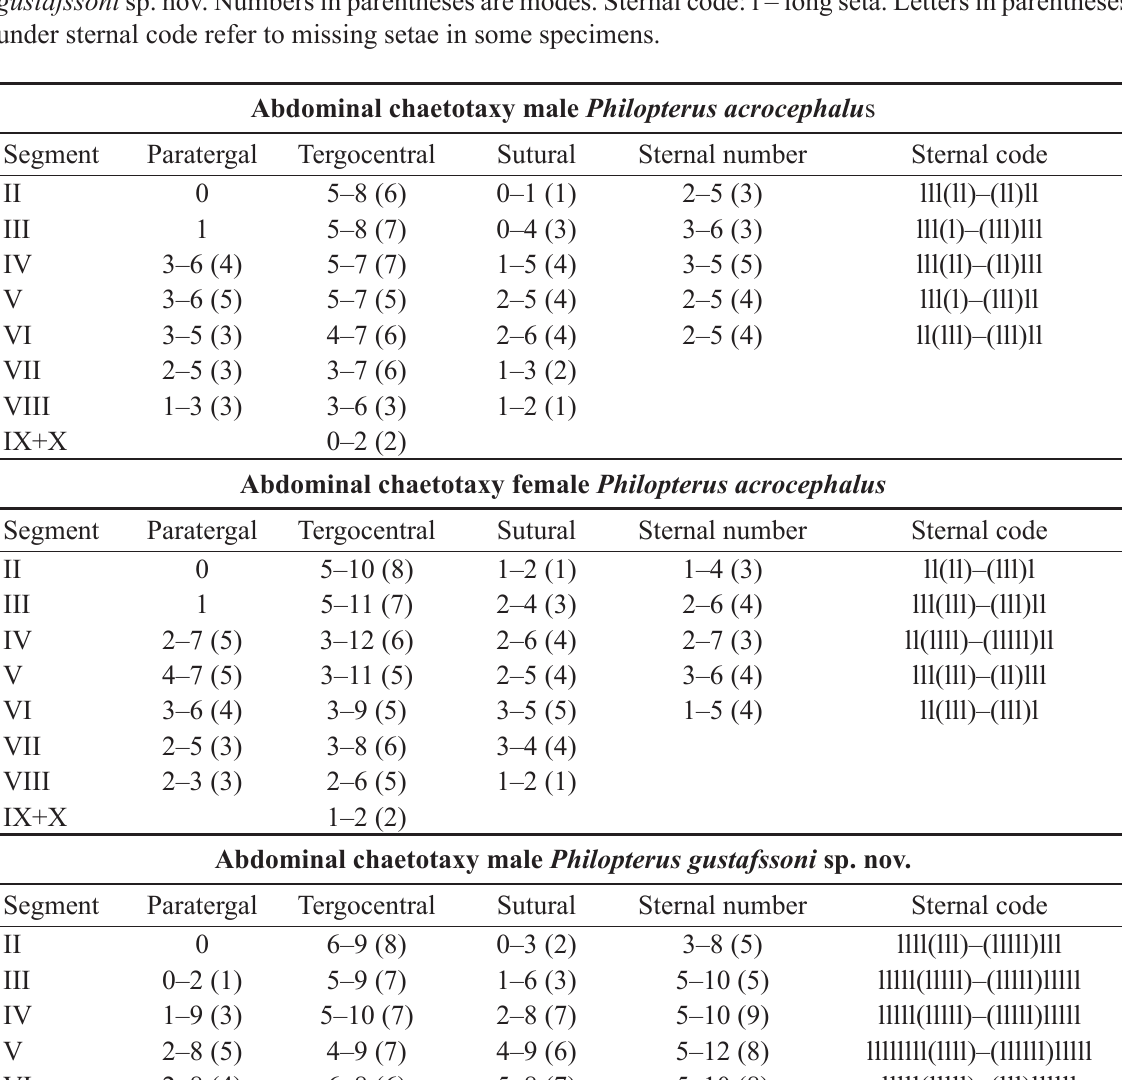
Table 2. Abdominal chaetotaxy for Philopterus acrocephalus Carriker, 1949 and Philopterus gustafssoni sp. nov. Numbers in parentheses are modes. Sternal code: l – long seta. Letters in parentheses under sternal code refer to missing setae in some